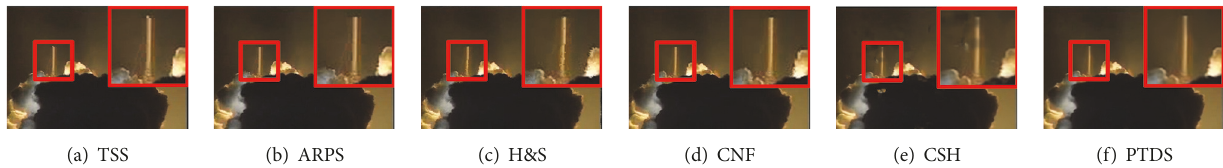
Figure 8: Interpolation frame 4 of sequence S6.